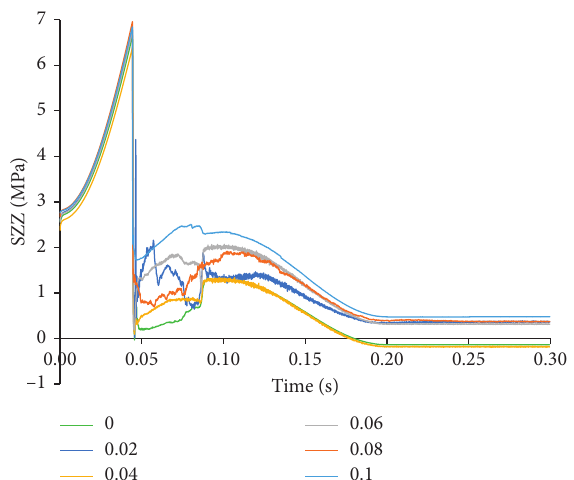
Figure 15: Curves of vertical stress varying with time of moni- toring points (LP �